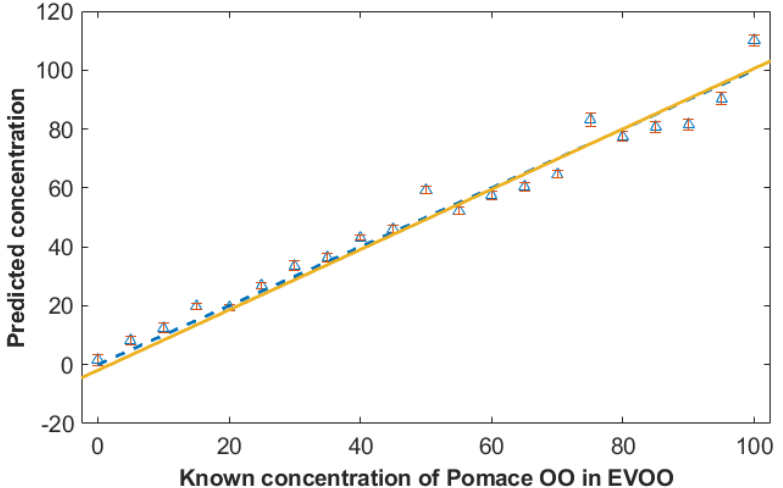
Figure 4. PLSR prediction model plots comparing the predicted actual concentrations for the pomace olive oil against the known level of this adulterant in extra virgin olive oil (EVOO). The data used in this model are from a handheld 1064 nm Raman spectrometer. PLSR was conducted using bootstrap validation ( n = 1000) and this figure shows the results from the 1000 test sets only (i.e., not the training data used for model construction). The symbols depict the means of the test set predictions with standard deviation error bars. The yellow solid line is the line of best fit from these models ( y = − 0.7054 + 1.0272* x ) and the blue dotted line the expected y = x line which would be from a perfect model. Table 1. PLSR results for the bootstrap models of the adulterated oils in EVOO with data collected in vial mode.